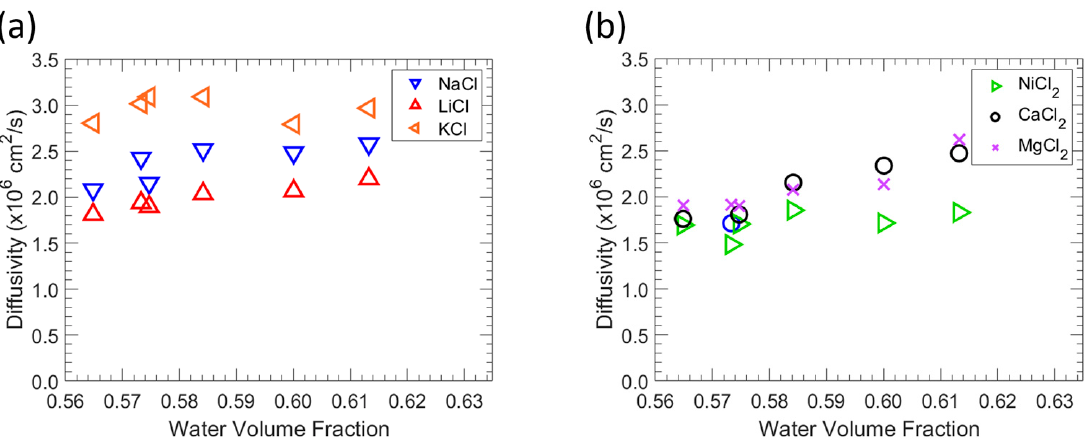
Figure 7. Correlation of diffusivity and water volume fraction in zwitterionic polymers. ( a ) Effect of water volume fraction on the monovalent salt diffusivity. ( b ) Effect of water volume fraction on the divalent salt diffusivity.